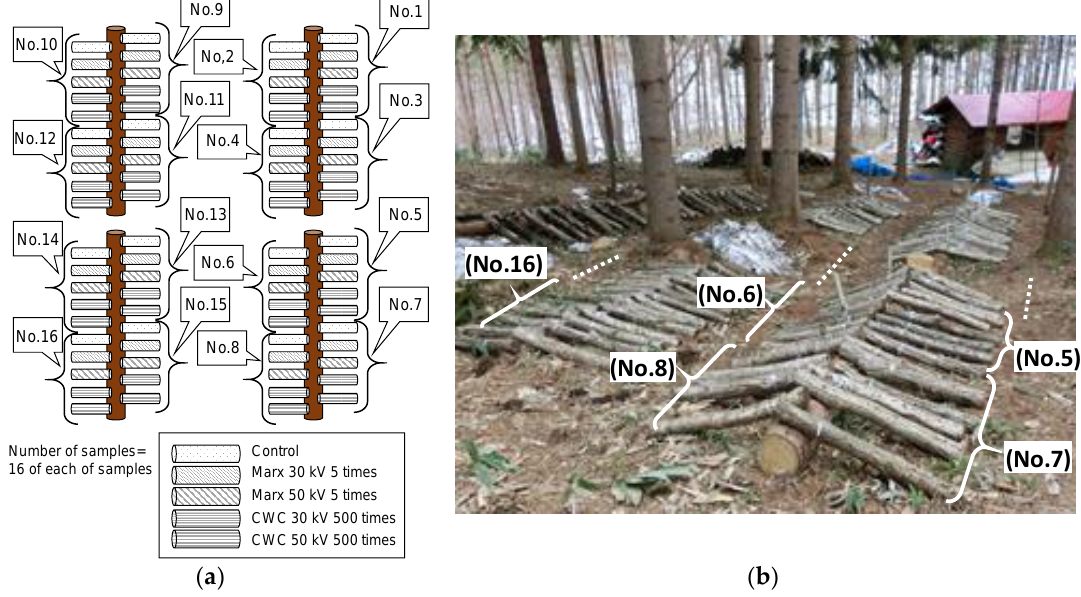
Figure 4. Arrangement ( a ) and photograph ( b ) of L. edodes logs for cultivation.